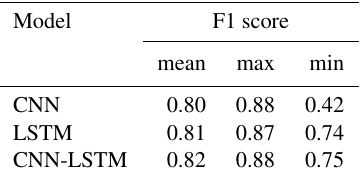
Table 9. F1 scores of the validation phase for CNN, LSTM, and CNN-LSTM models with 100 random training–validation splits.